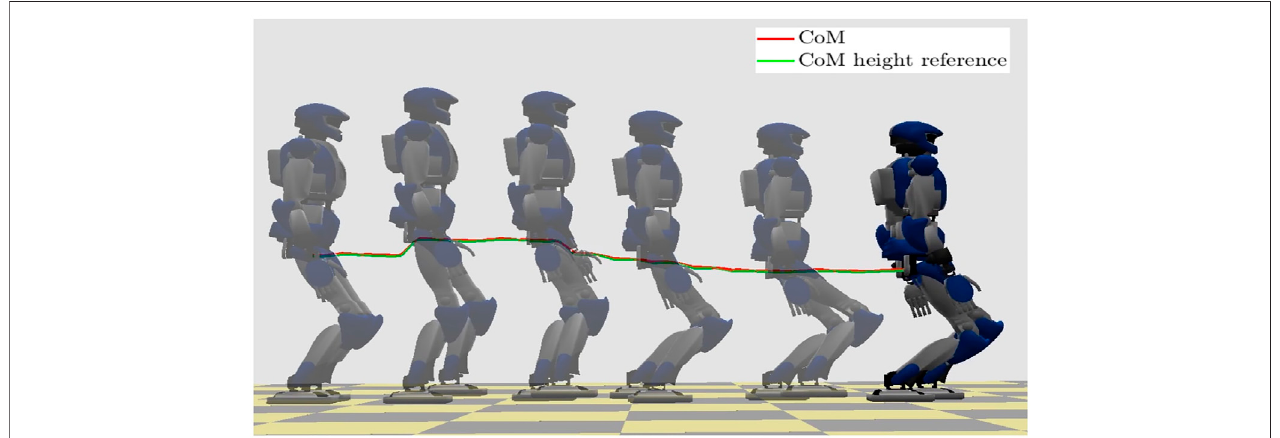
FIGURE 9 | Walking on fl at ground with variable CoM height: stroboscopic motion.